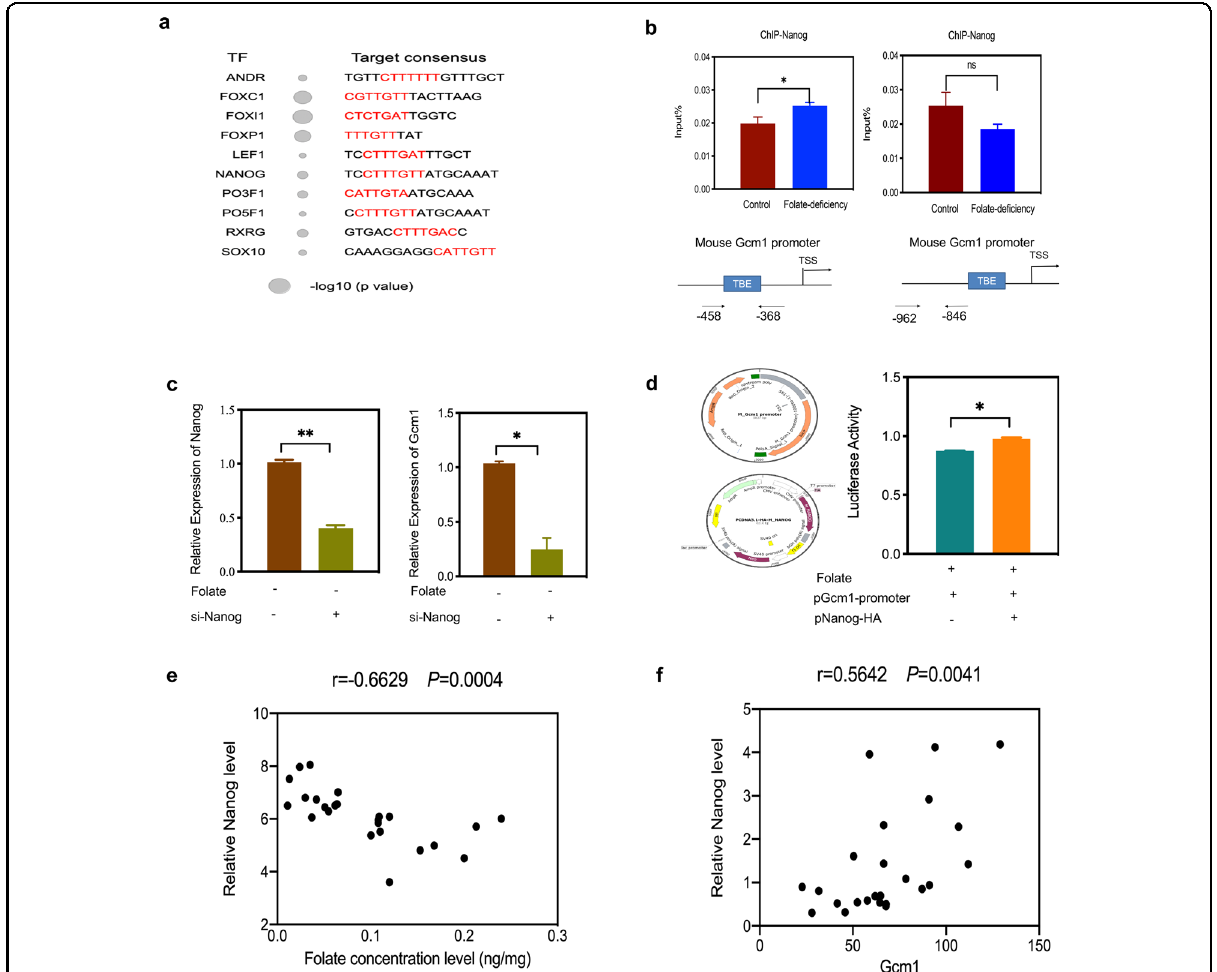
Fig. 5 Nanog upregulates Gcm1 promoter activity. a Enrichment scores of transcription factor binding motifs in the mouse Gcm1 promoter. TF transcription factor. The size of the circle represents the − log10 ( P value). b Nanog recognizes the Gcm1 promoter. C57BL/6 mESCs were subjected to ChIP analysis using Nanog antibodies. The immunoprecipitated complexes were analyzed by PCR. The TBE sites are located within 1 kb upstream of the Gcm1 promoter; the arrows represent the start and end sites of the PCR amplicons (bottom panel). c Ef fi ciency of siRNA-mediated Nanog depletion and the expression of Gcm1 at mRNA level. C57BL/6 mESCs with folate de fi ciency were transfected with either control scramble siRNA or Nanog-siRNA, and the expression levels were determined 24 h post transfection by real-time RT-PCR. Left panel: quanti fi cation of Nanog in control scramble siRNA and si-Nanog cells; right panel: quanti fi cation of Gcm1 in control scrambles siRNA and si-Nanog cells. d Analysis of Gcm1 promoter- driven luciferase reporter activity in folate-de fi cient mESCs cotransfected with control plasmid or Nanog plasmid. Experimental mESCs were transfected with 1.5 µg of pGcm1-promoter, and control mESCs were transfected with 5.5 µg of Nanog-HA. The structures of the Gcm1 promoter reporter construct and the Nanog-HA construct are shown in the left panel. At 48 h post transfection, the cells were harvested for luciferase